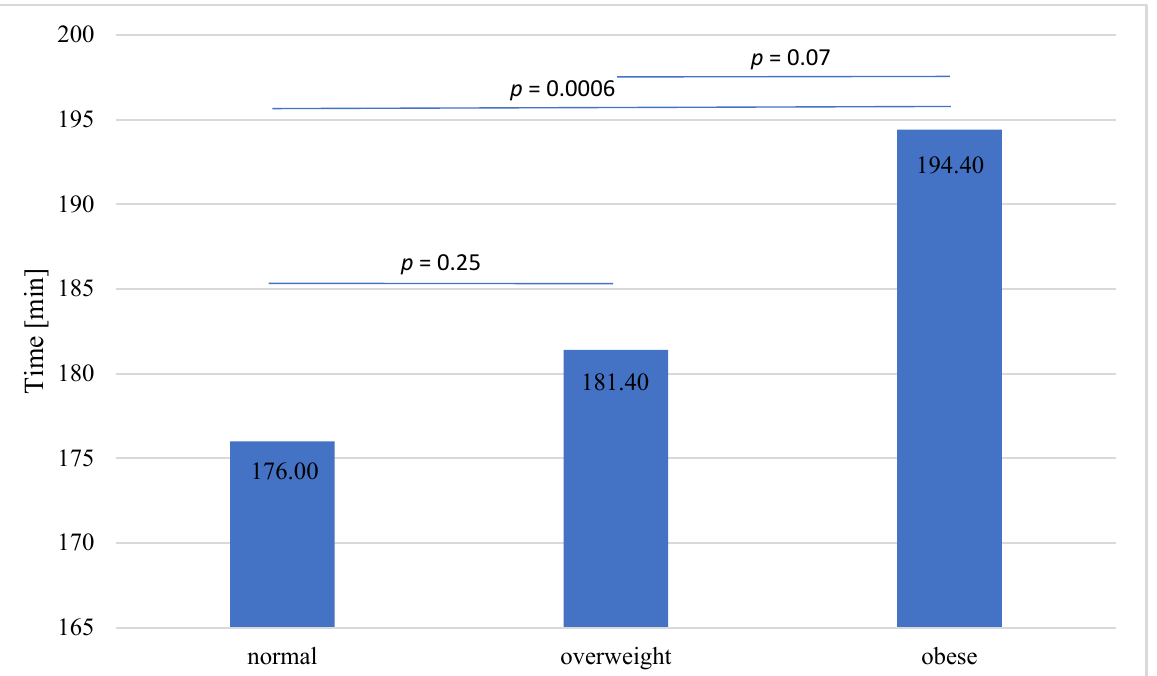
Figure 2. Warm ischemia time in BMI stratified groups. The groups differed significantly in respect of the DGF incidence. DGF was signifi- cantly more frequent in patients with obesity than in overweight ( p = 0.0015) and normal weight patients ( p = 0.0005). There was no difference between overweight and normal- weight patients ( p = 0.86). In the study group, there were 86 cases of adverse events requiring reoperation within 30 days after transplantation (19.86%). The short-term surgical complications, reoperation rate, incidence of lymphocele, vascular complications and wound dehiscence were more frequent in obese KTRs. The analysis of postoperative adverse events stratified by type and the comparison between BMI cohorts are reported in Table 2.